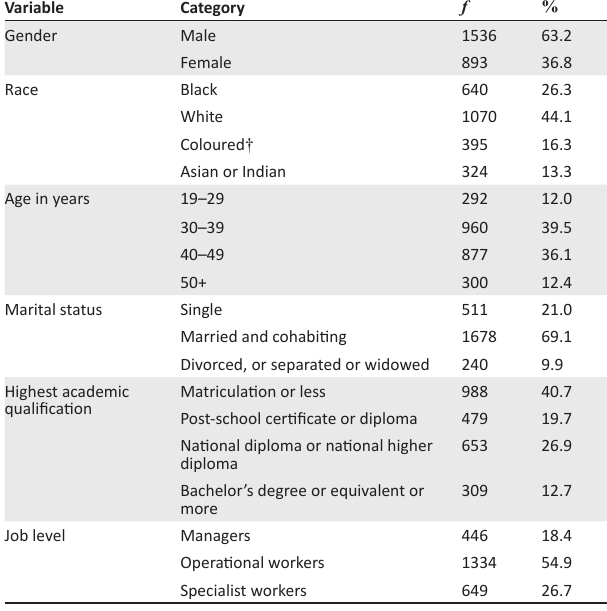
TABLE 1: Biographical and demographic characteristics of respondents ( n =